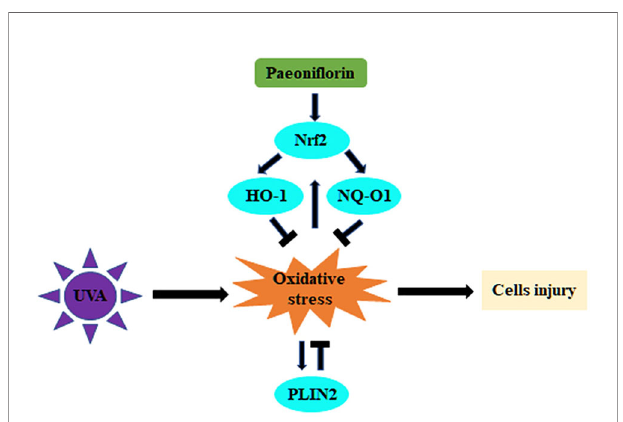
FIGURE 6 | Schematic illustration of this study showing the regulation of UVA-related oxidative stress by PF via Nrf2/HO-1/NQ-O1 signaling pathway or